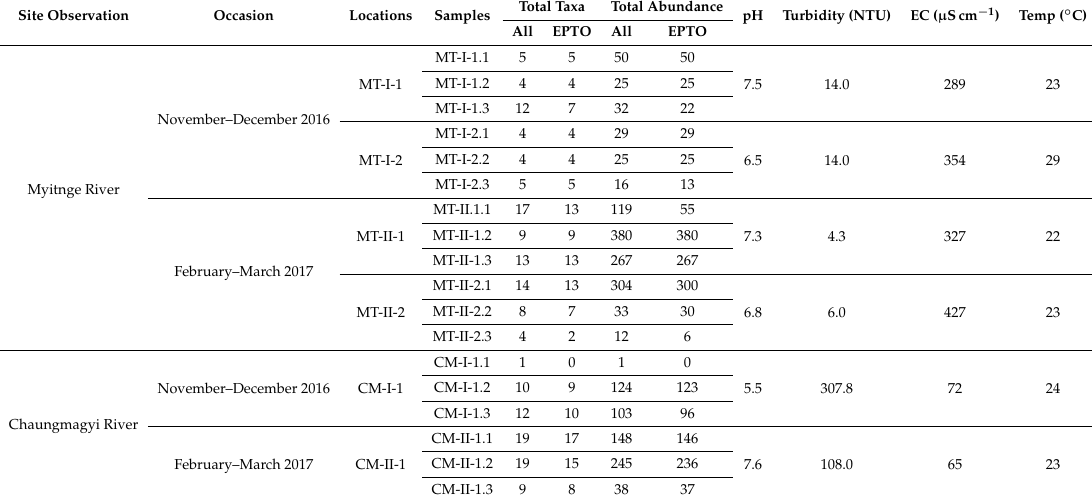
Table 1. Collected number of all taxa and Ephemeroptera, Plecoptera, Trichoptera and Odonata (EPTO) with their abundance data and four physico-chemical variables at each sample at each site of both study rivers for two sampling